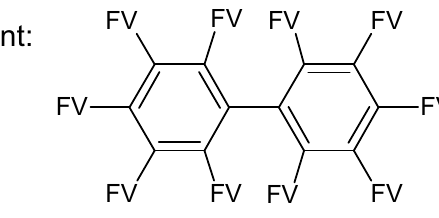
Figure A7. Substructures for GC–MS Challenge 8. FV = free valence.